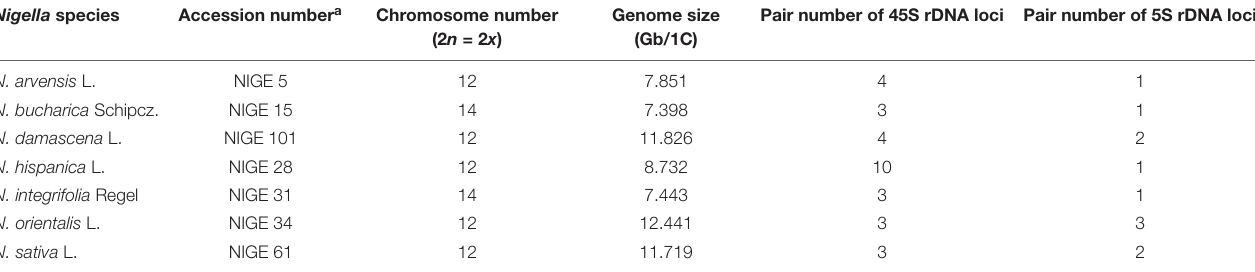
Genome size Pair number of 45S rDNA loci Pair number of 5S rDNA loci (2 n = 2 x ) (Gb/1C)